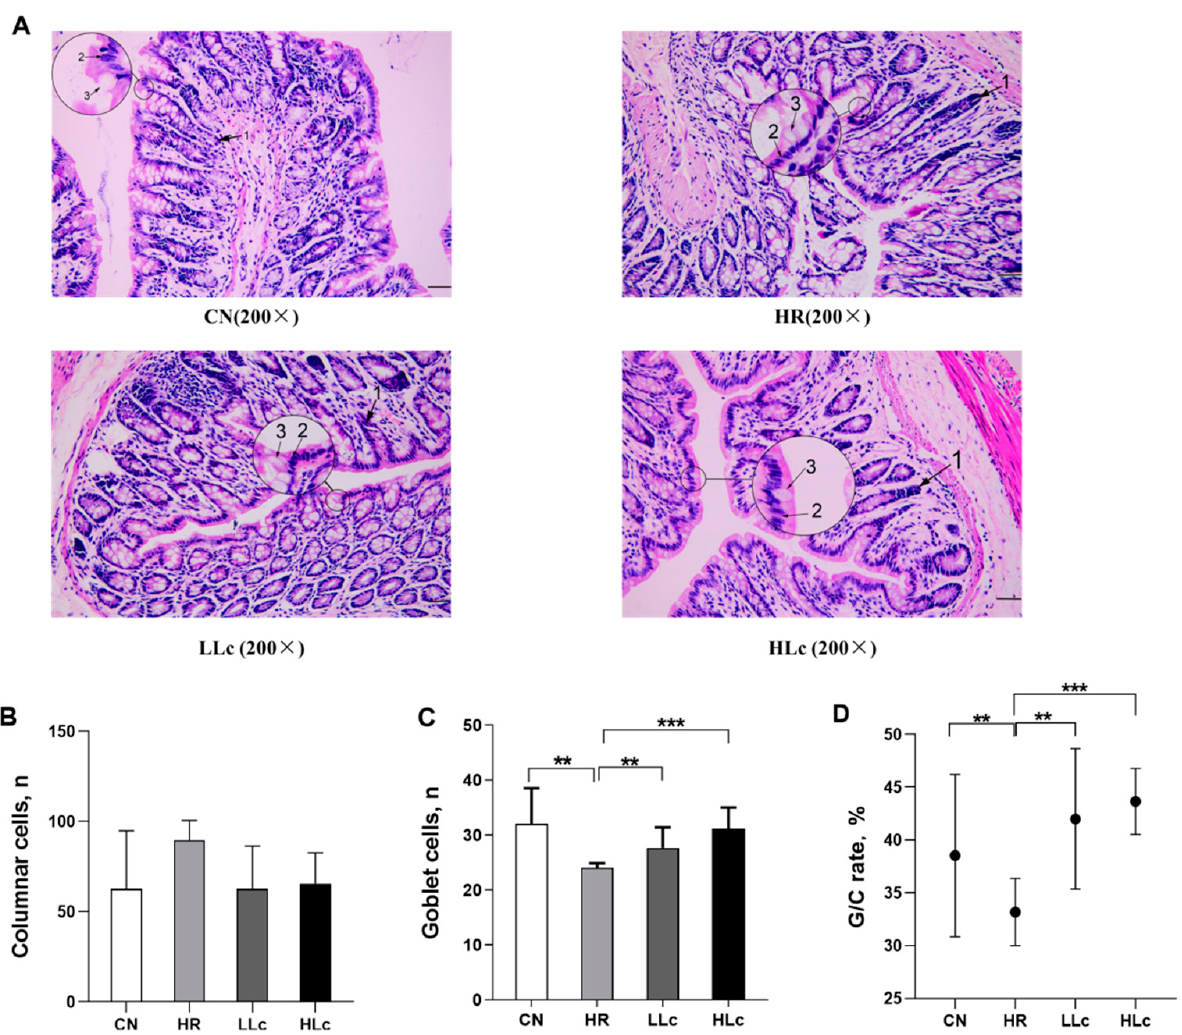
Figure 1. Pathological evaluation and the number of goblet cells of colon tissues of anti-TB drugs and Lactobacillus casei for 42 days. ( A ) Pathological conditions were observed under 200-fold field; 1 indicated irregular crypts, 2 indicated columnar cell, 3 indicated goblet cell, Scale bars, 50 µ m. ( B ) Columnar cells; ( C ) Goblet cells; ( D ) The proportion of goblet cells to columnar cells. Values are mean ± SD, n = 5 per group. CN: control group, HR: Isoniazid + rifampicin model group, LLc: HR + low dose L. casei ATCC334 group, HLc: HR + high dose L. casei ATCC334 group. ** indicates p < 0.01, *** indicates p < 0.001.